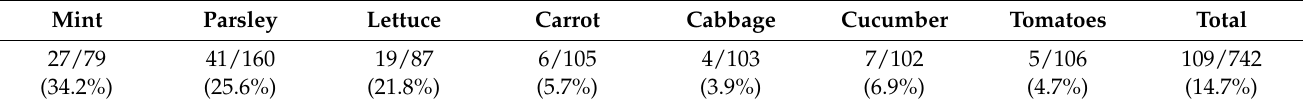
Table 1. Contamination of vegetables by Salmonella